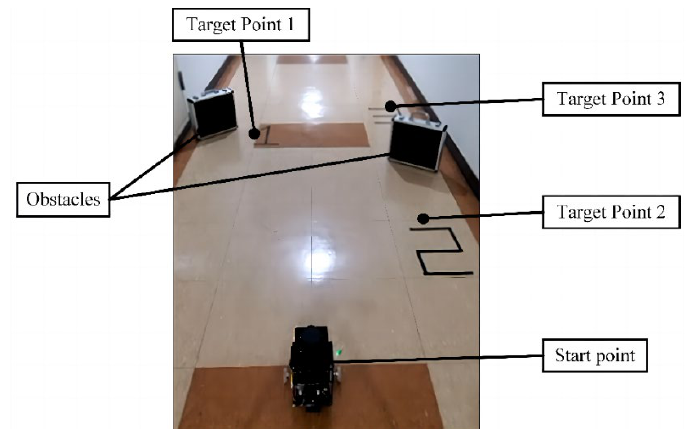
Figure 13. Real scene for Owlbot navigation testing.